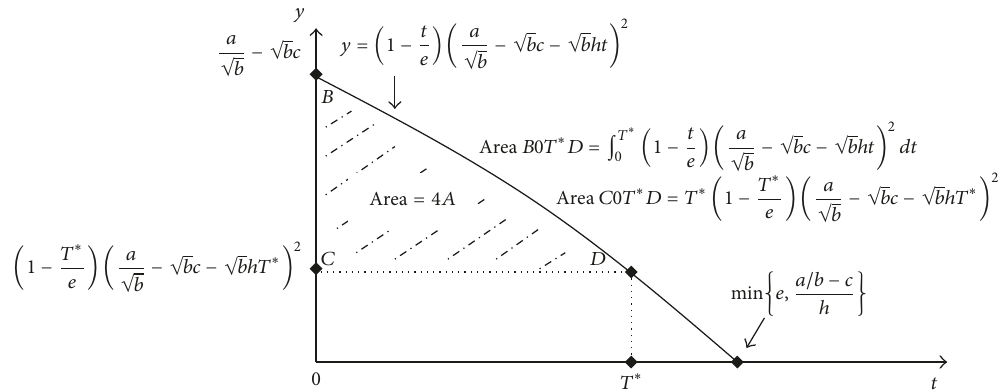
Figure 1: The optimal inventory cycle 𝑇 ∗